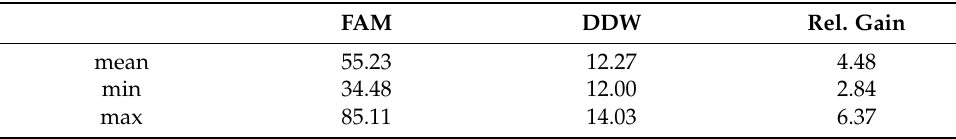
Figure 13. Relative gains. Table 3. Brightness and relative gain statistics of each